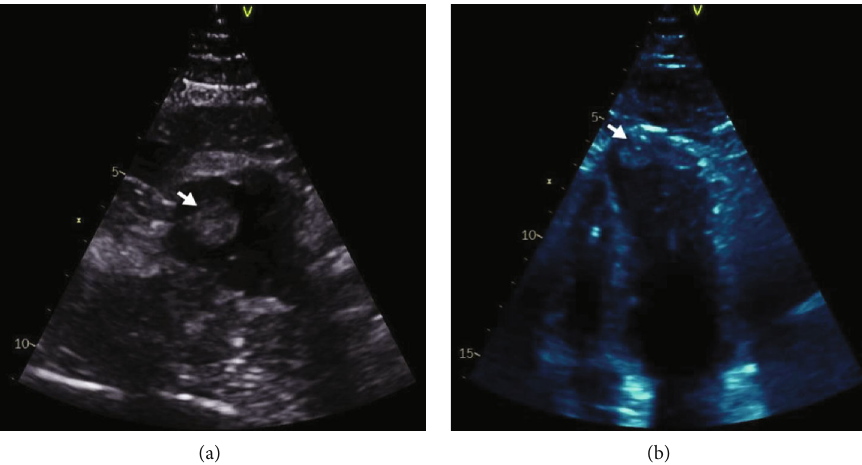
Figure 2: Post device upgrade ECHO. (a) Parasternal short axis view and (b) apical 4-chamber view of transthoracic echocardiogram demonstrating the left ventricular apical thrombus (arrow).